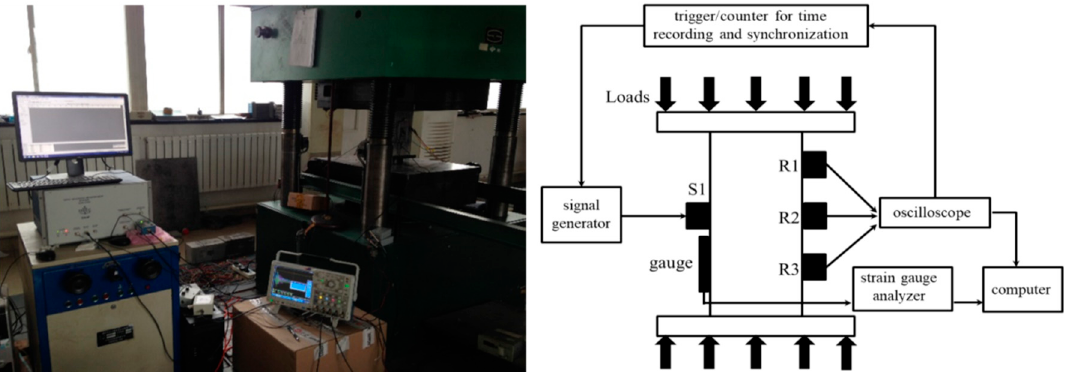
Figure 3. A photograph and schematic layout of measurement procedure.